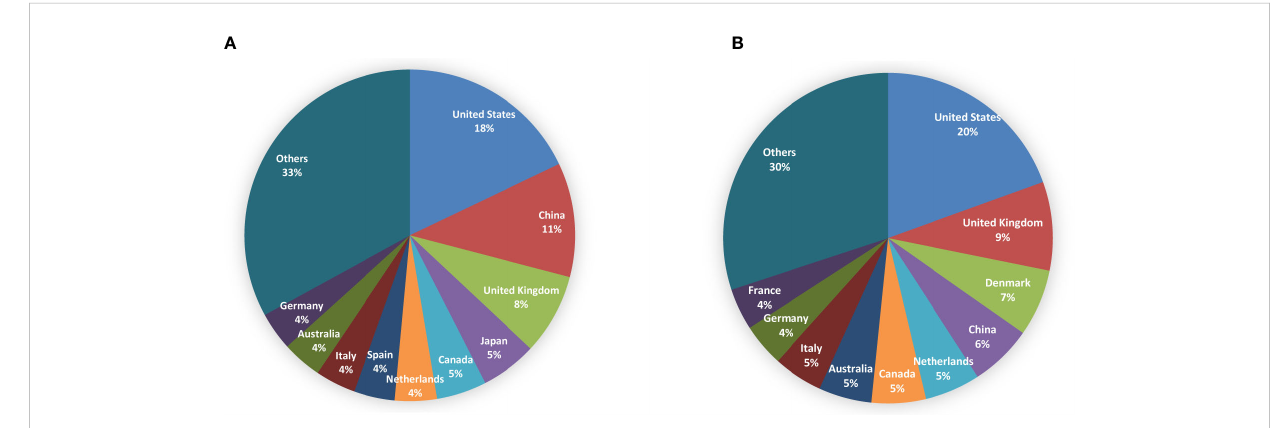
FIGURE 3 Pie charts for top 10 countries/regions contributing to publications (A) and citations (B) in the fi eld of non-fasting